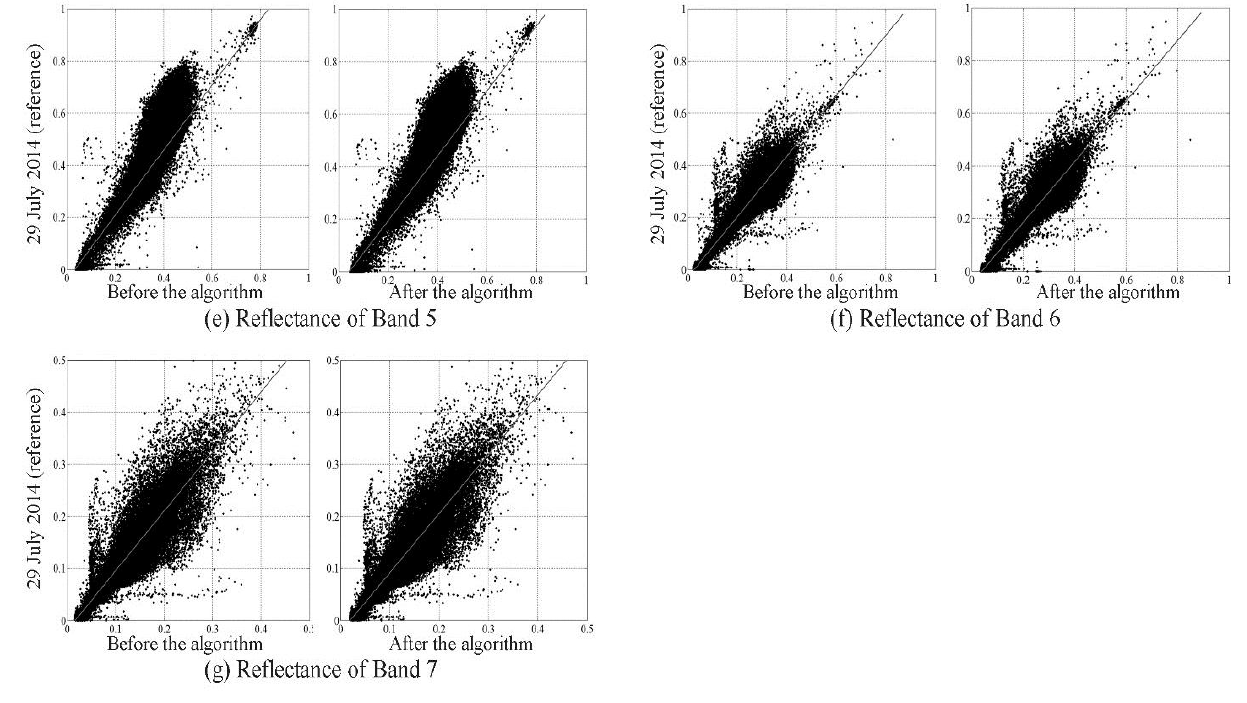
Figure 8. Scatterplots of Bands 1–7 for cloud-covered pixels on the 13 July 2014 image. The 13 July 2014 image before the cloud removal (before) vs. the 29 July 2014 image (as reference). The 13 July 2014 image after the cloud removal (after) vs. the 29 July 2014 image. ( a – g ) are Bands 1–7,